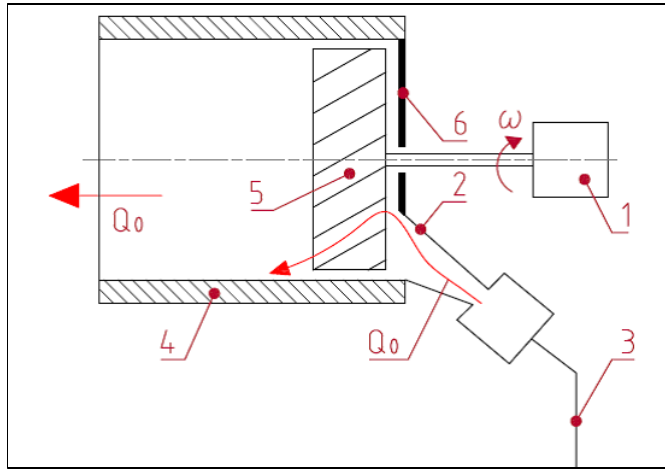
Figure 15. Schematic of a partial admission turbine: 1- generator; 2- nozzle block; 3- working gas source; 4- casing; 5- impeller; 6- separation